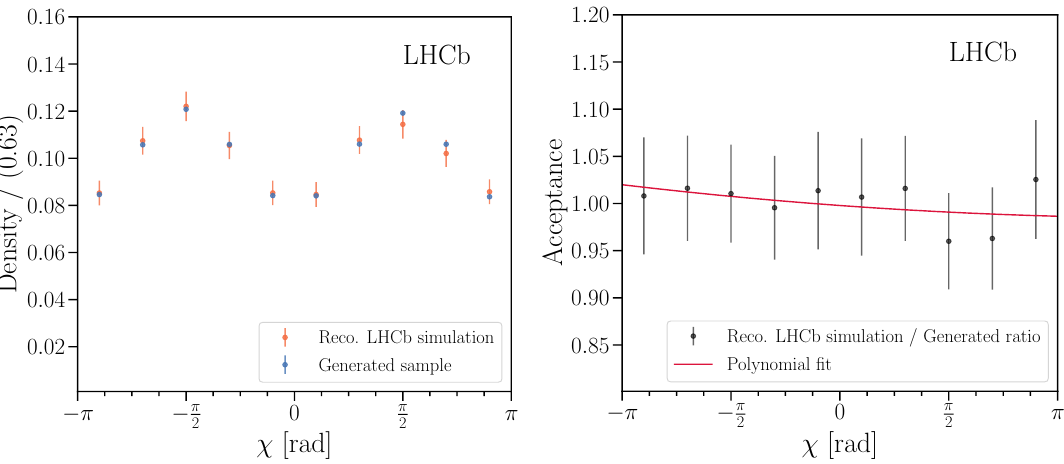
Figure 5 . Comparison of reconstructed χ distribution in a fully-simulated B 0 → D ∗− D ∗ +